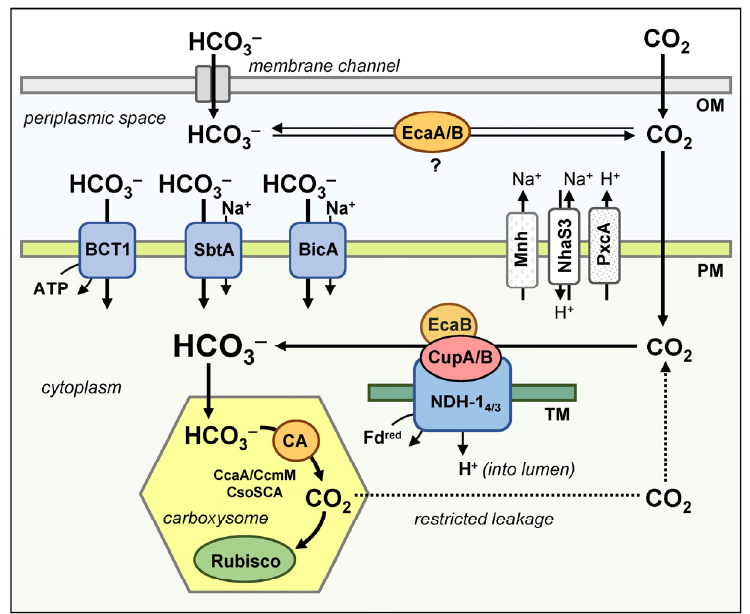
Figure 4. CCM in model strains of cyanobacteria. The periplasmic CAs, EcaA and EcaB are also shown, but their involvement in the CCM has not yet been confirmed. Abbreviations: OM—outer membrane; PM—plasma membrane; TM—thylakoid membrane.